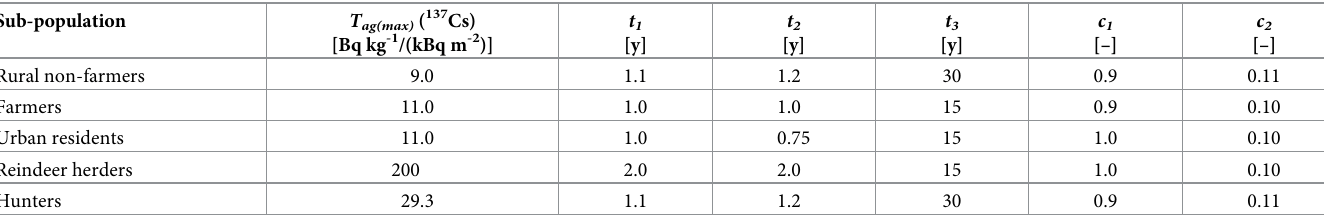
Table 1. Parameter values used to determine the internal effective dose for various sub-populations.